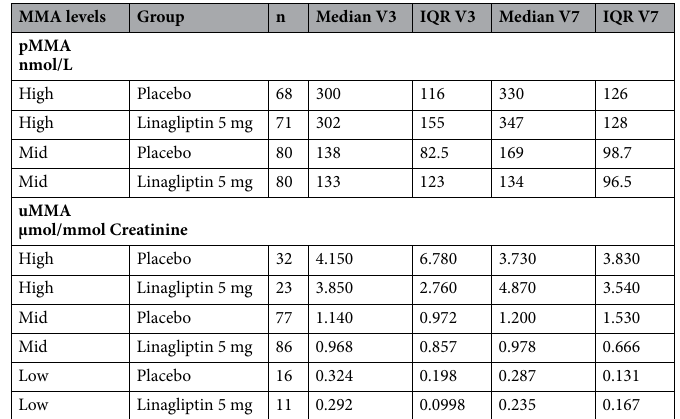
Table 5. Patient characteristics and pMMA and uMMA values of a subset of individuals from the MARLINA trial. Median and IQR of pMMA and uMMA at V3 and V7 group by treatment group and MMA levels. IQR interquartile range; pMMA plasma methylmalonic acid; uMMA urine methylmalonic acid; V3 baseline; V7 end of study.